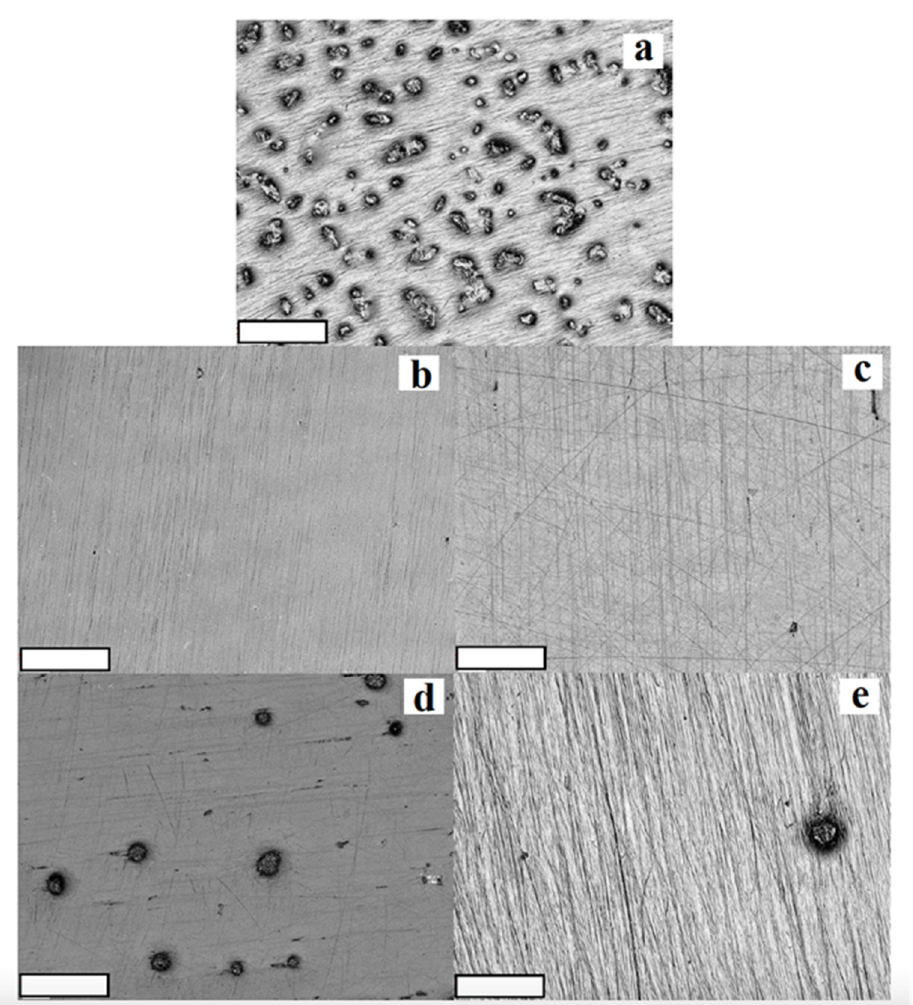
Figure 2. Scanning electron microscopy images of chairside CAD/CAM reinforced lithium disilicate ceramic; ( a ) non-polished; ( b ) polished with Dialite ceramic polishing; ( c ) polished with OptraFine ceramic polishing; ( d ) polished with Diacomp composite polishing; ( e ) polished with Astropol composite polishing.